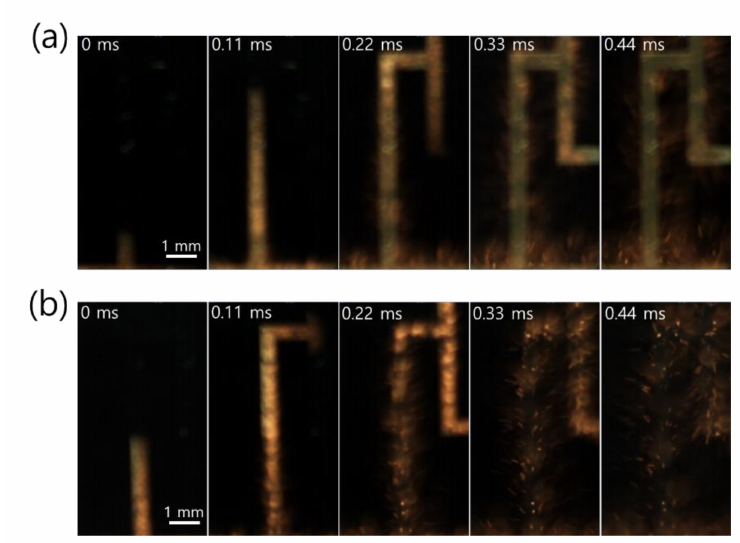
Figure 4. High-speed snapshots of the explosive reaction propagation in Pd/Al-iRMS, from left to right. ( a ) Pd/Al-iRMS grown on a bare Si-wafer; ( b ) Pd/Al-iRMS grown on a RuO x -buffered